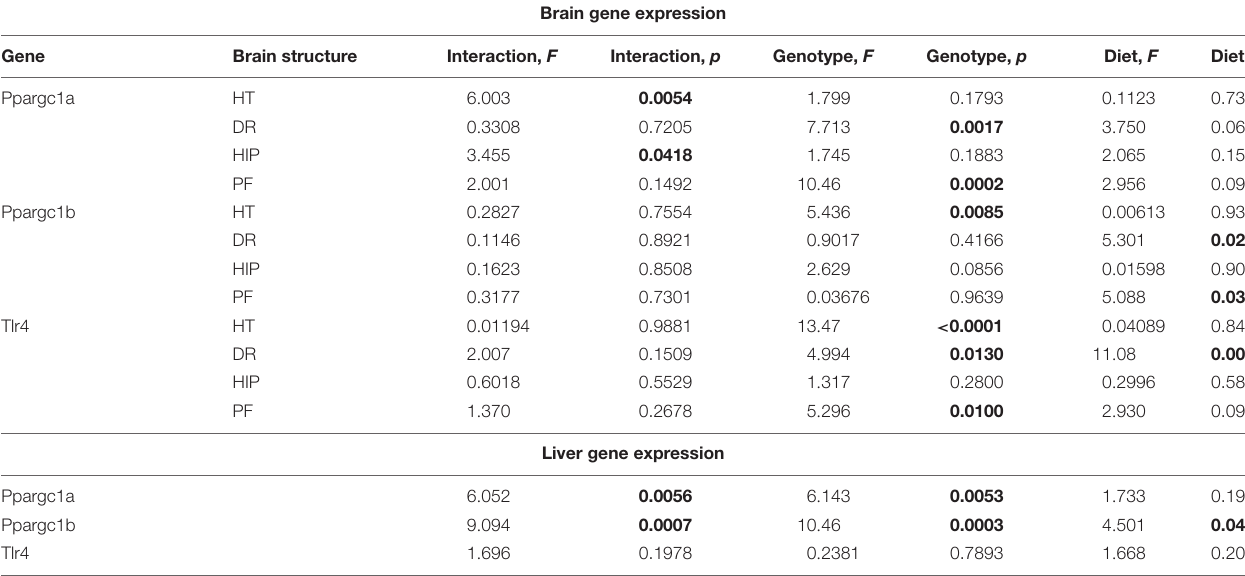
TABLE 2 | Two-way ANOVA results for statistical analysis of Ppargc1a and b and Tlr4 gene expression. Brain gene expression Gene Brain structure Interaction, F Interaction, p Genotype, F Genotype, p Diet, F